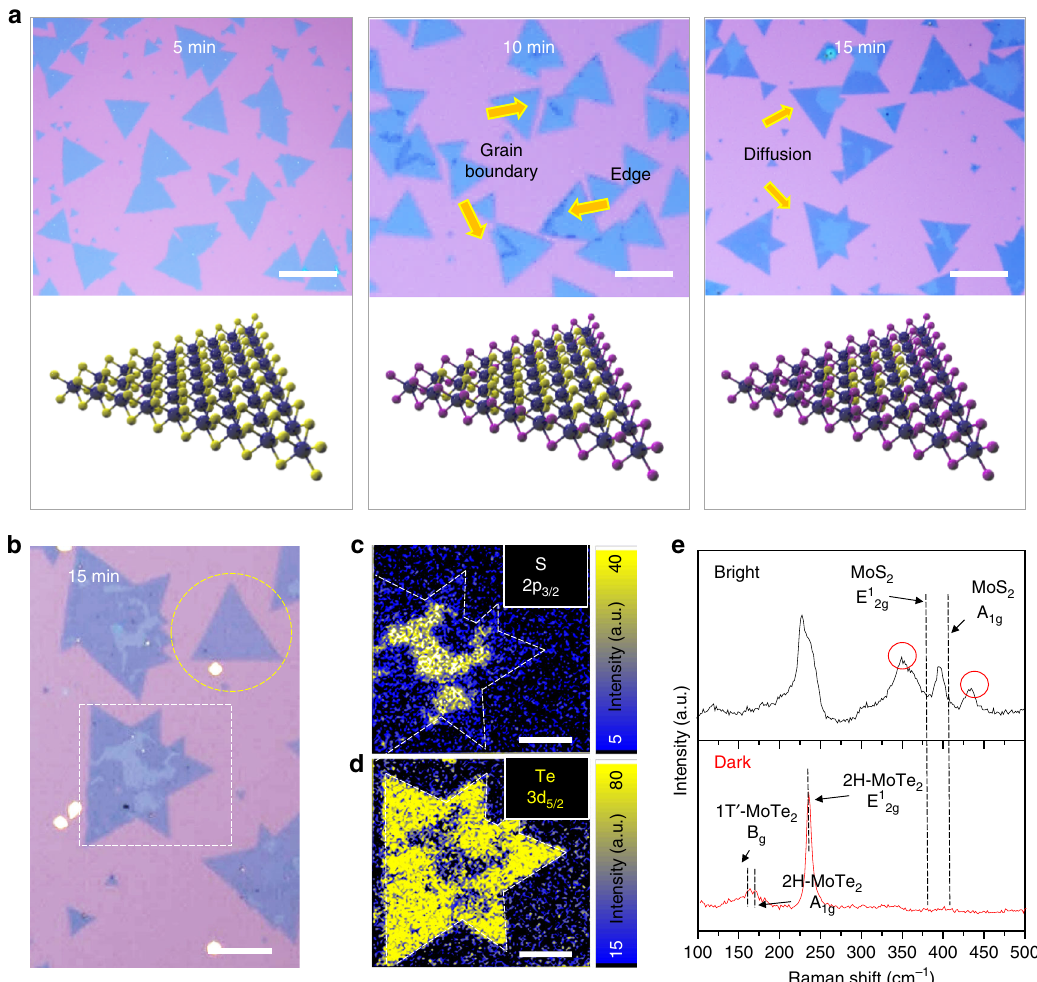
Fig. 2 Time evolution of conversion from MoS 2 to MoTe 2 . a Optical images and the corresponding schematics of the initial growth stages: 5, 10, and 15 min. The dark color indicates the fully converted MoTe 2 region from MoS 2 . Conversion is favored at the edges and grain boundaries; scale bars, 50 μ m. b Ampli fi ed optical image of the sample grown for 15 min. The MoS 2 fl ake is completely converted to MoTe 2 in the yellow-dotted circle; scale bars, 50 μ m. c , d XPS mapping image of tellurized MoS 2 fl ake for S 2p 3/2 ( c ) and Te 3d 5/2 ( d ) in the white-dotted square in b ; scale bars, 30 μ m. A high Te content was detected in the dark region (no sulfur content was detected), while the S content (~ 20%) is seen in the bright region. e Raman spectra of bright and dark regions. The dark region shows the Raman spectrum exclusively from MoTe 2 (1T ′ − 2H mixed phase). Some unknown peaks (349 and 435 cm − 1 in red circles) in the bright region, which are far from MoS 2 and MoTe 2 Raman peaks are